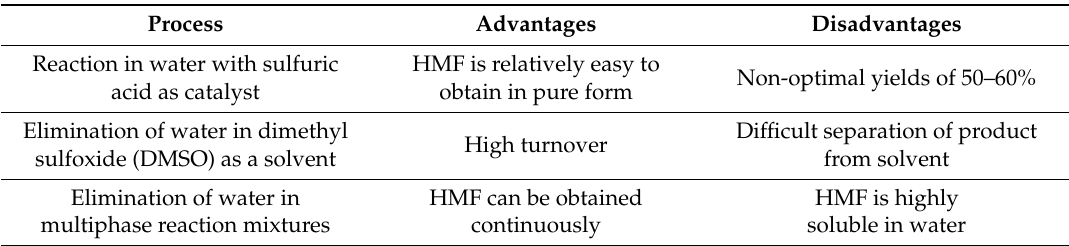
Table 1. Three process alternatives for the synthesis of 5-hydroxymethyl-furfural (HMF) from fructose (according to the literature [12]).